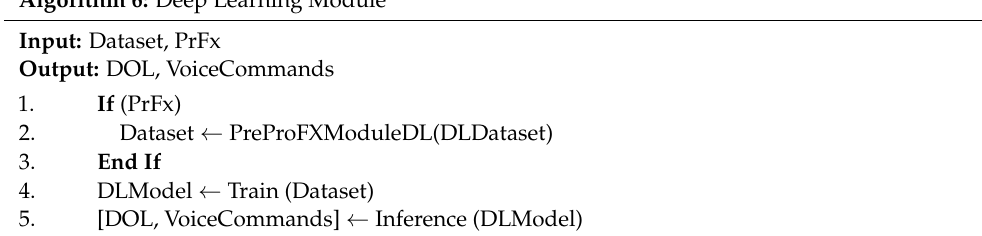
Algorithm 6: Deep Learning